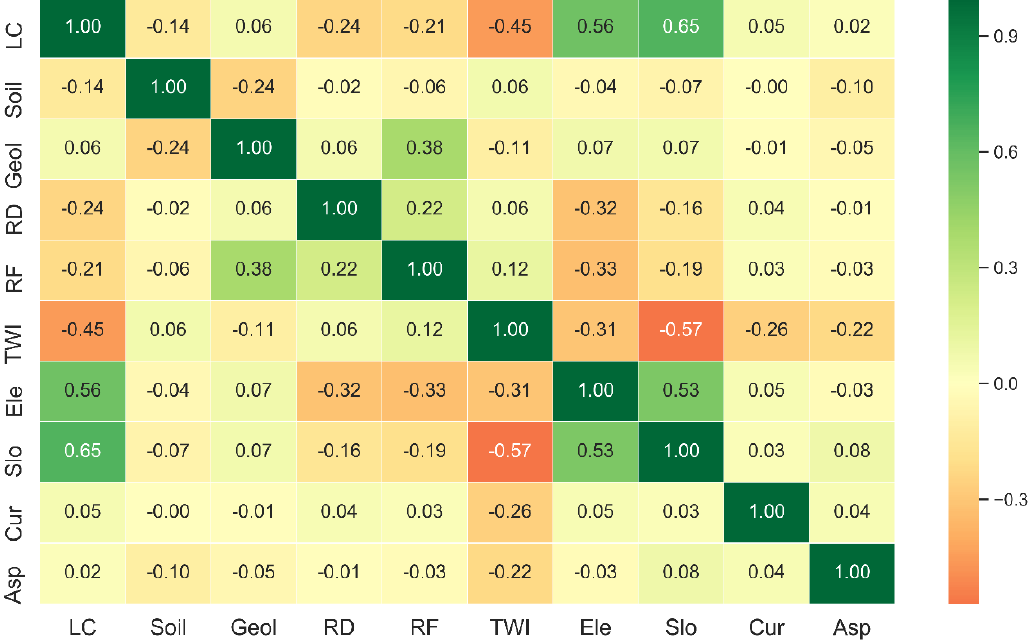
Figure 5. Pearson correlation of the flash flood predictors. LC: landuse/landcover; Soil: Soil type; Geol: Lithology; RD: River density; RF: Rainfall; TWI: Topographic Wetness Index; Ele: Elevation; Slo: Slope; Cur: Curvature; Asp: Aspect.